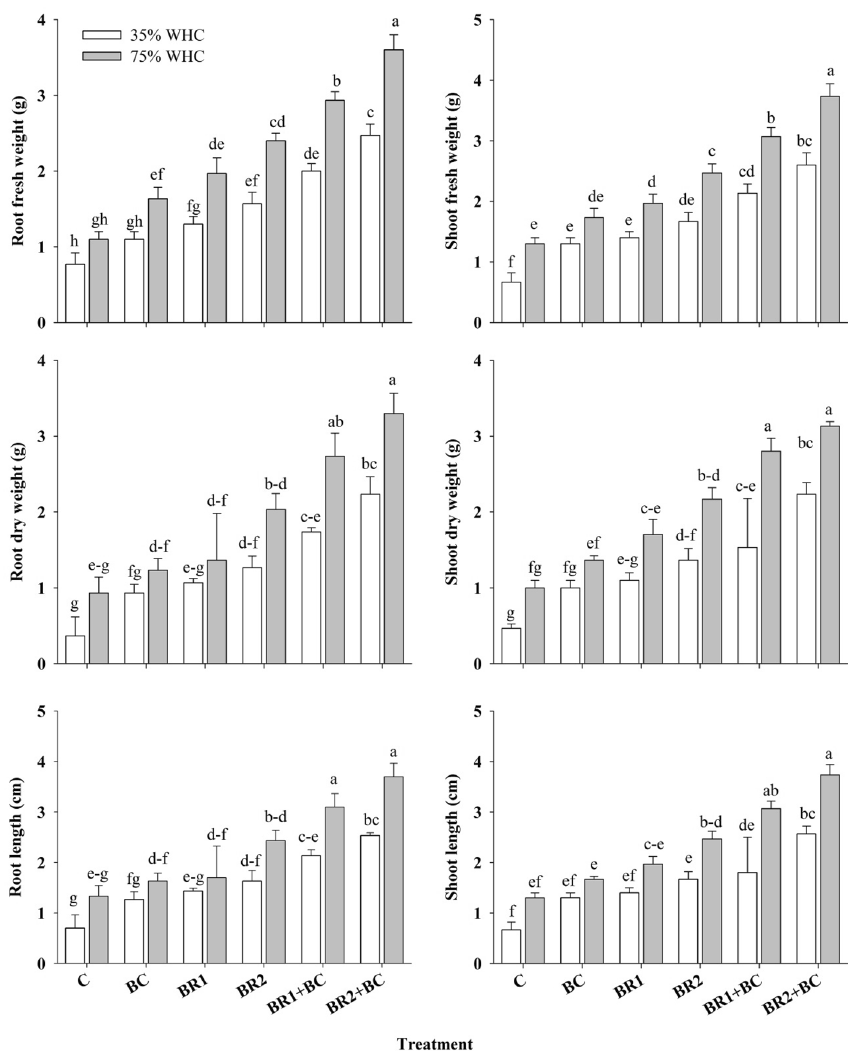
Figure 1. Efficacy of sole and combined application of BR and BC on enhancing different growth parameters of wheat under 35% WHC and 75% WHC. Bars show means of three replicates. Different error bars represent SD. Different letters indicate significant difference at p ≤ 0.05; LSD Test ( 75 WHC well-watered, 35 WHC drought stress, C control, BR1 1 μmol foliar applied 24-epibrassinolide, BR2 3 μmol foliar applied 24-epibrassinolide, BC timber waste